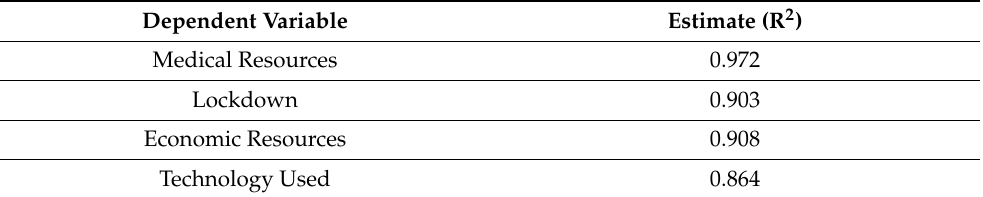
Table 5. Squared multiple